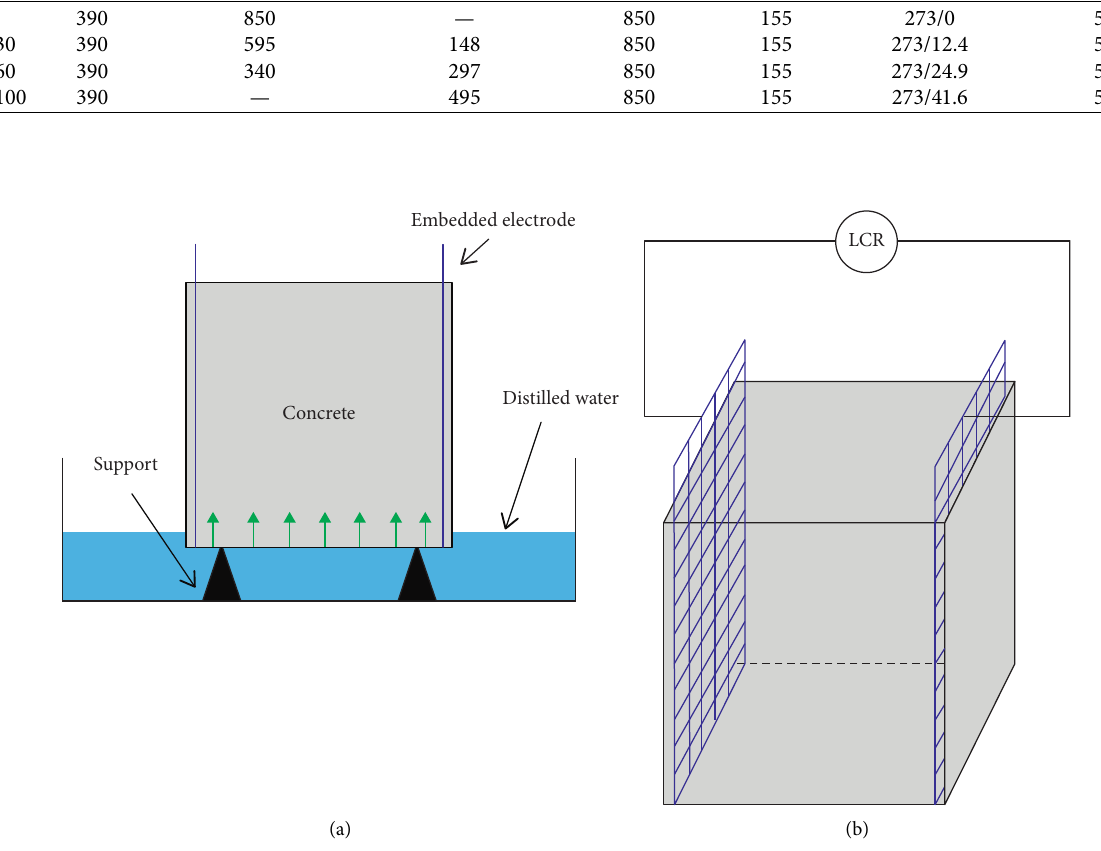
Figure 2: Experimental device: (a) schematic diagram of water absorption test; (b) schematic diagram of electrical resistance